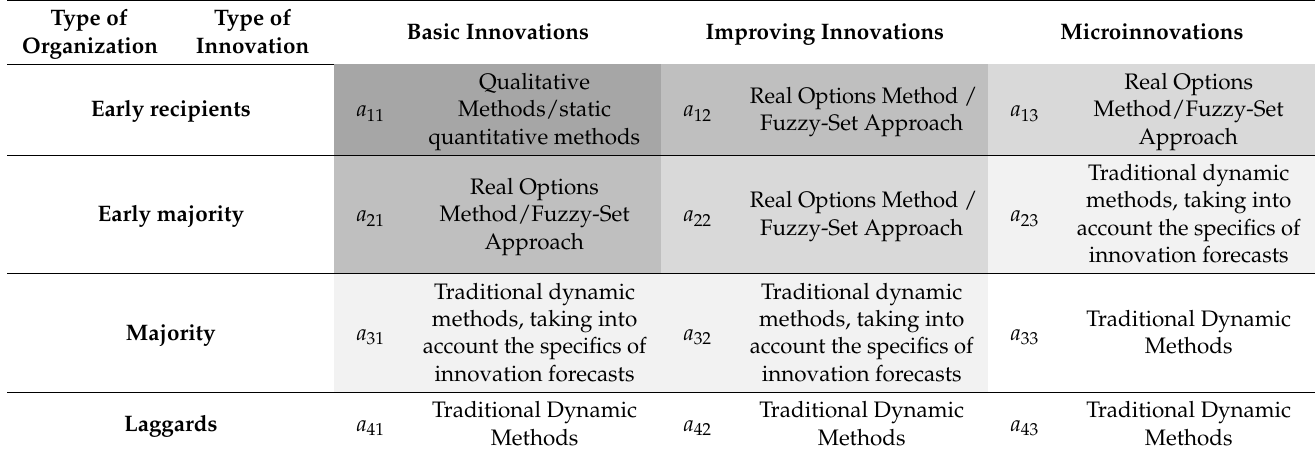
Table 1. Matrix of methods for economic analysis of innovative